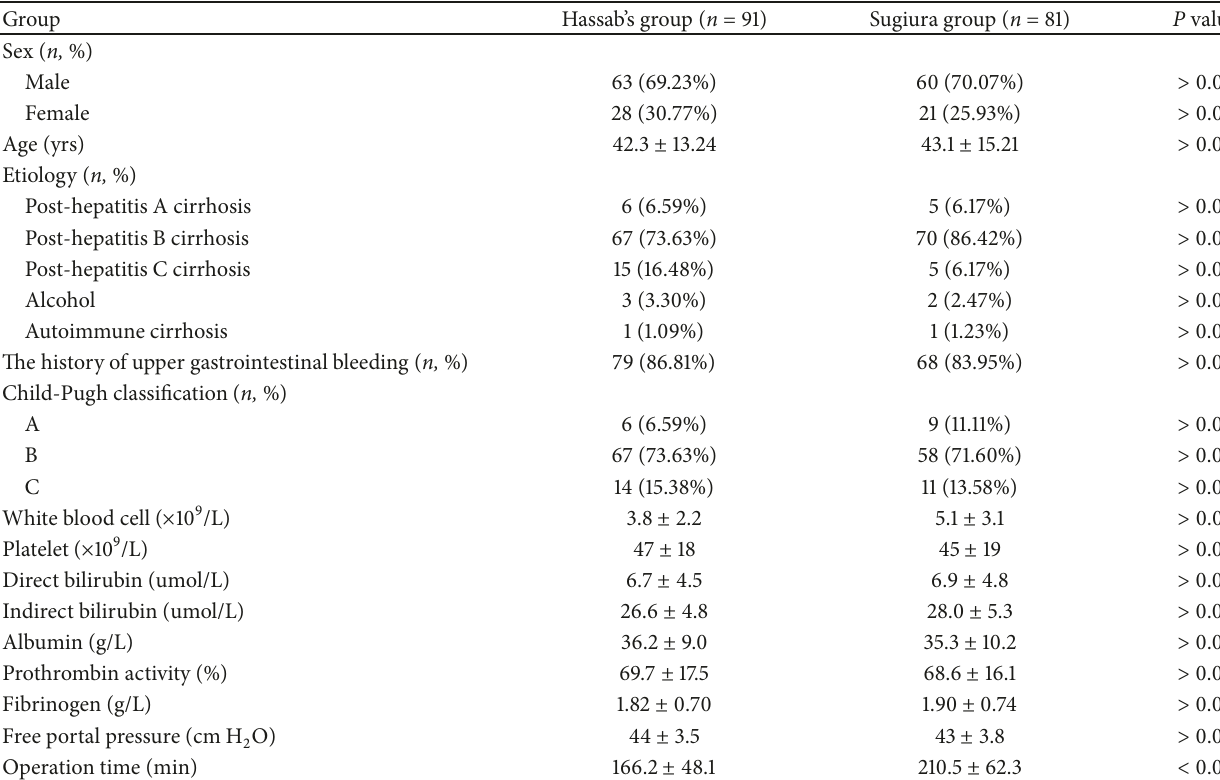
Table 1: Baseline characteristics of the included patients.